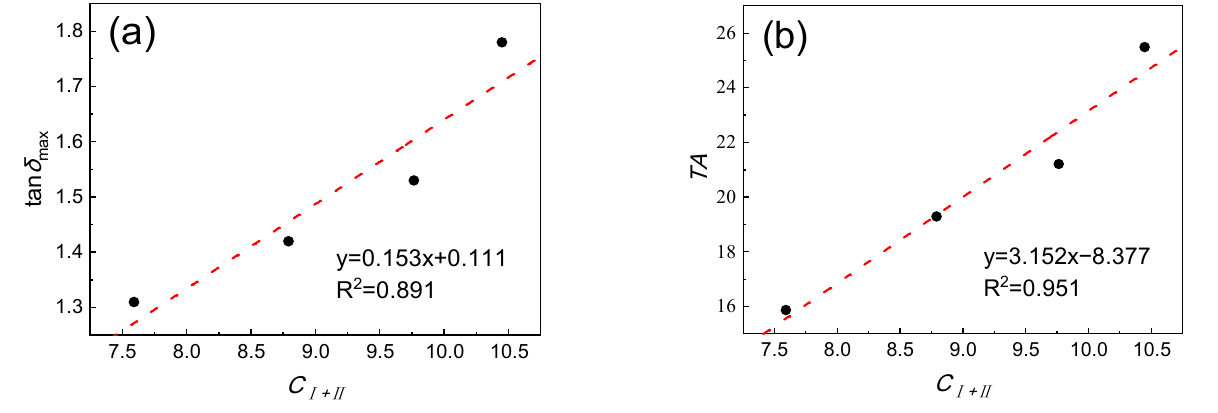
Figure 8. Linear regression curve. ( a ) C I+II -tan δ max . ( b ) C I+II - TA.